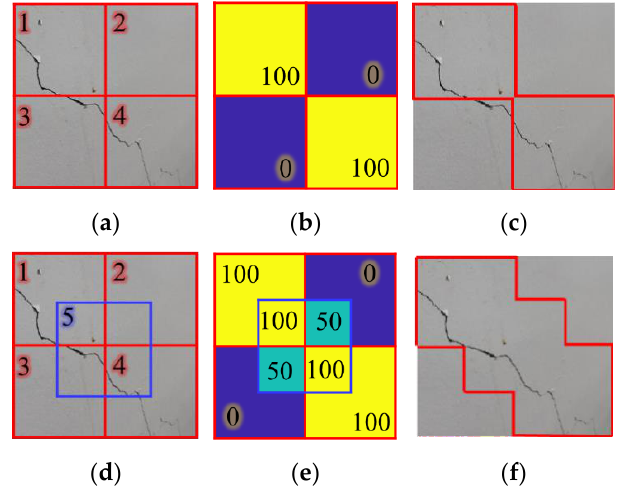
Figure 5. Performance enhancement using overlapped windows: ( a ) sliding windows without overlapping; ( b ) softmax output of the windows; ( c ) detection result from sliding windows without overlapping; ( d ) sliding windows with overlapping; ( e ) average softmax output of the windows; and ( f ) enhanced detection result with sliding windows with overlapping and probability map.